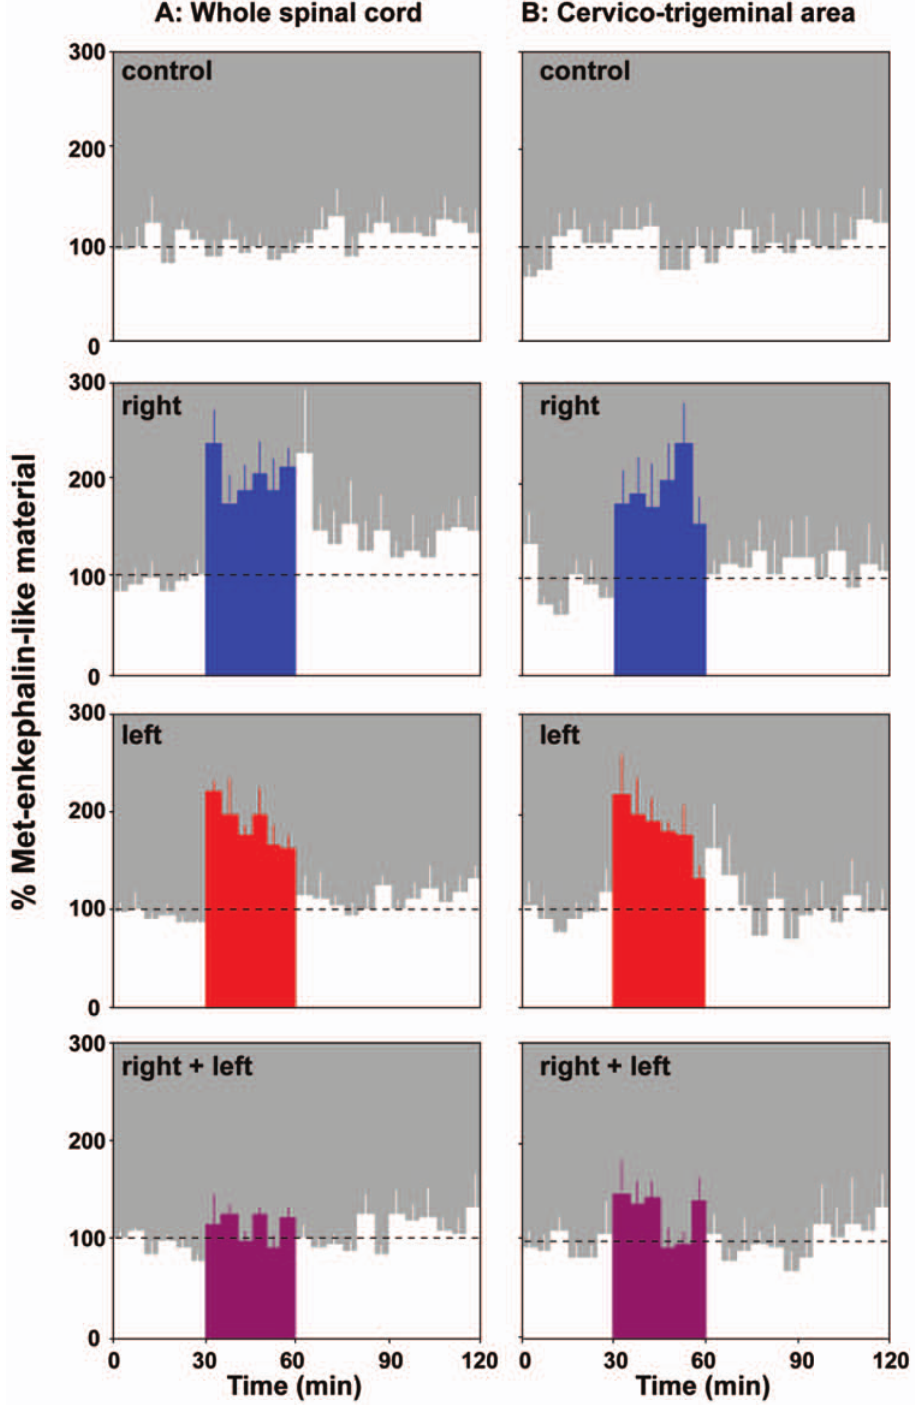
Figure 1. Effects of mechanical stimuli on the release of Met-enkephalin-like material (MELM) during the perifusion of the whole spinal cord (A) or the cervico-trigeminal area (B). Following a 30-minutes control period (spontaneous release: A=2.4 6 0.6 and B=1.9 6 0.2 pg/ 5 min), calibrated noxious pinches (10 N/cm 2 , 10 s duration, 3 times per min) were applied repetitively for 30 minutes (black areas) in four groups of animals in a Latin square experimental design. From top to bottom: no stimulation (controls), stimulation of the right hind paw, stimulation of the left hind paw, stimulation of both the right and the left hind paws. Note that MELM release increased markedly when pinches were applied to either hind paw. No effect was seen when both hind paws were stimulated simultaneously. Results are expressed in terms of percentage of the mean basal value observed during the control period. ANOVA and post hoc PLSD Fisher tests indicated highly significant effects of both individual factors of variation and their interactions (see table S1), respectively.